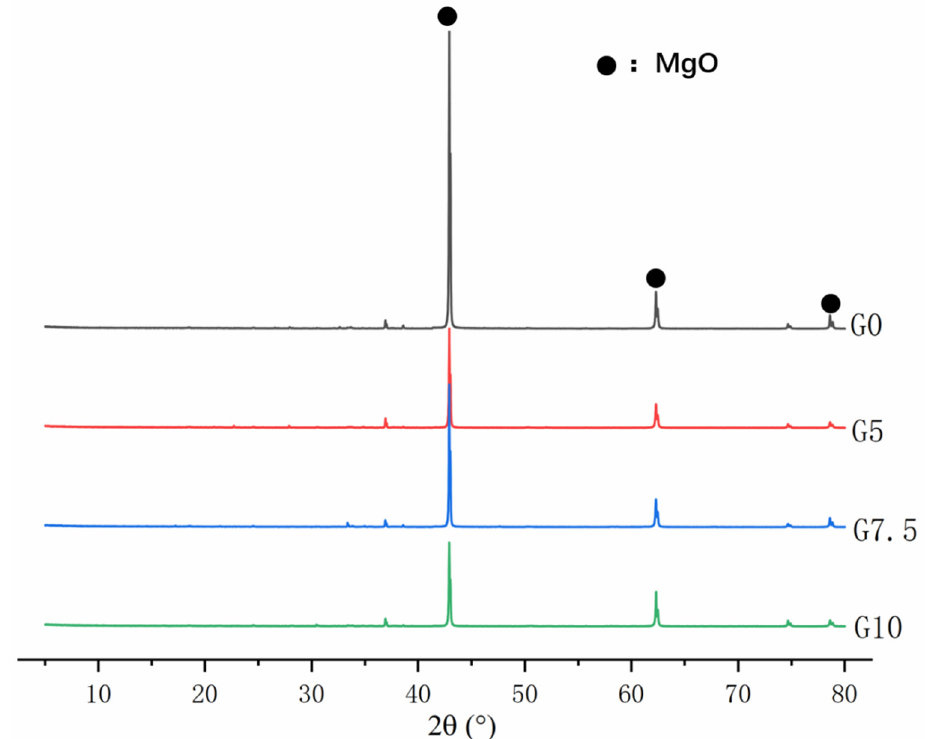
Figure 2. XRD patterns of water-glass-modified MgO with different doping levels.